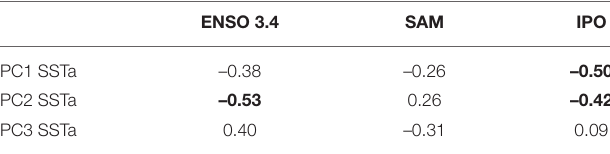
Correlation coefficients significantly different from zero at the 95% confidence level are indicated in